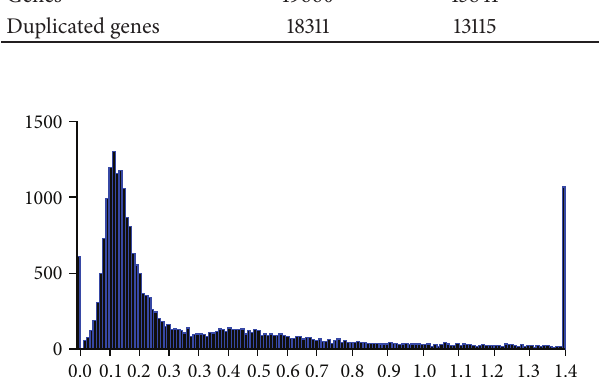
Figure 3: Synonymous distance between paralogs in